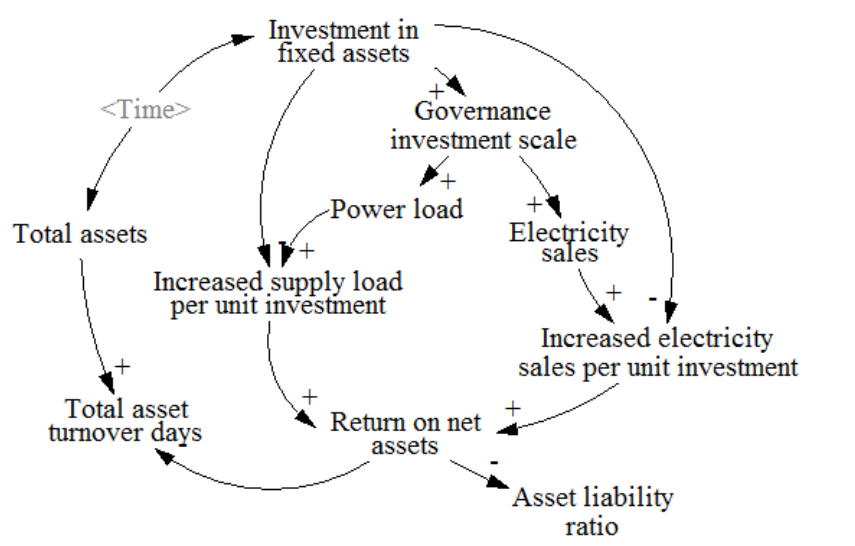
Figure 5. Cause and effect analysis diagram of governance investment subsystem of grid company .